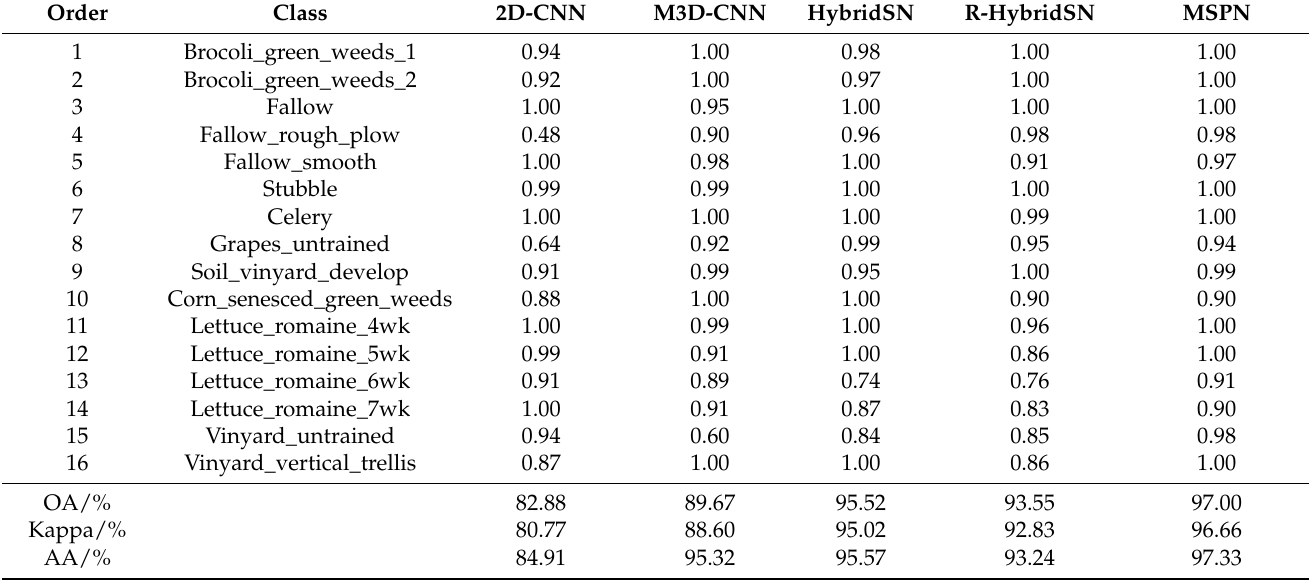
Table 3. Accuracy comparison of different methods for 0.5% samples of Salinas.